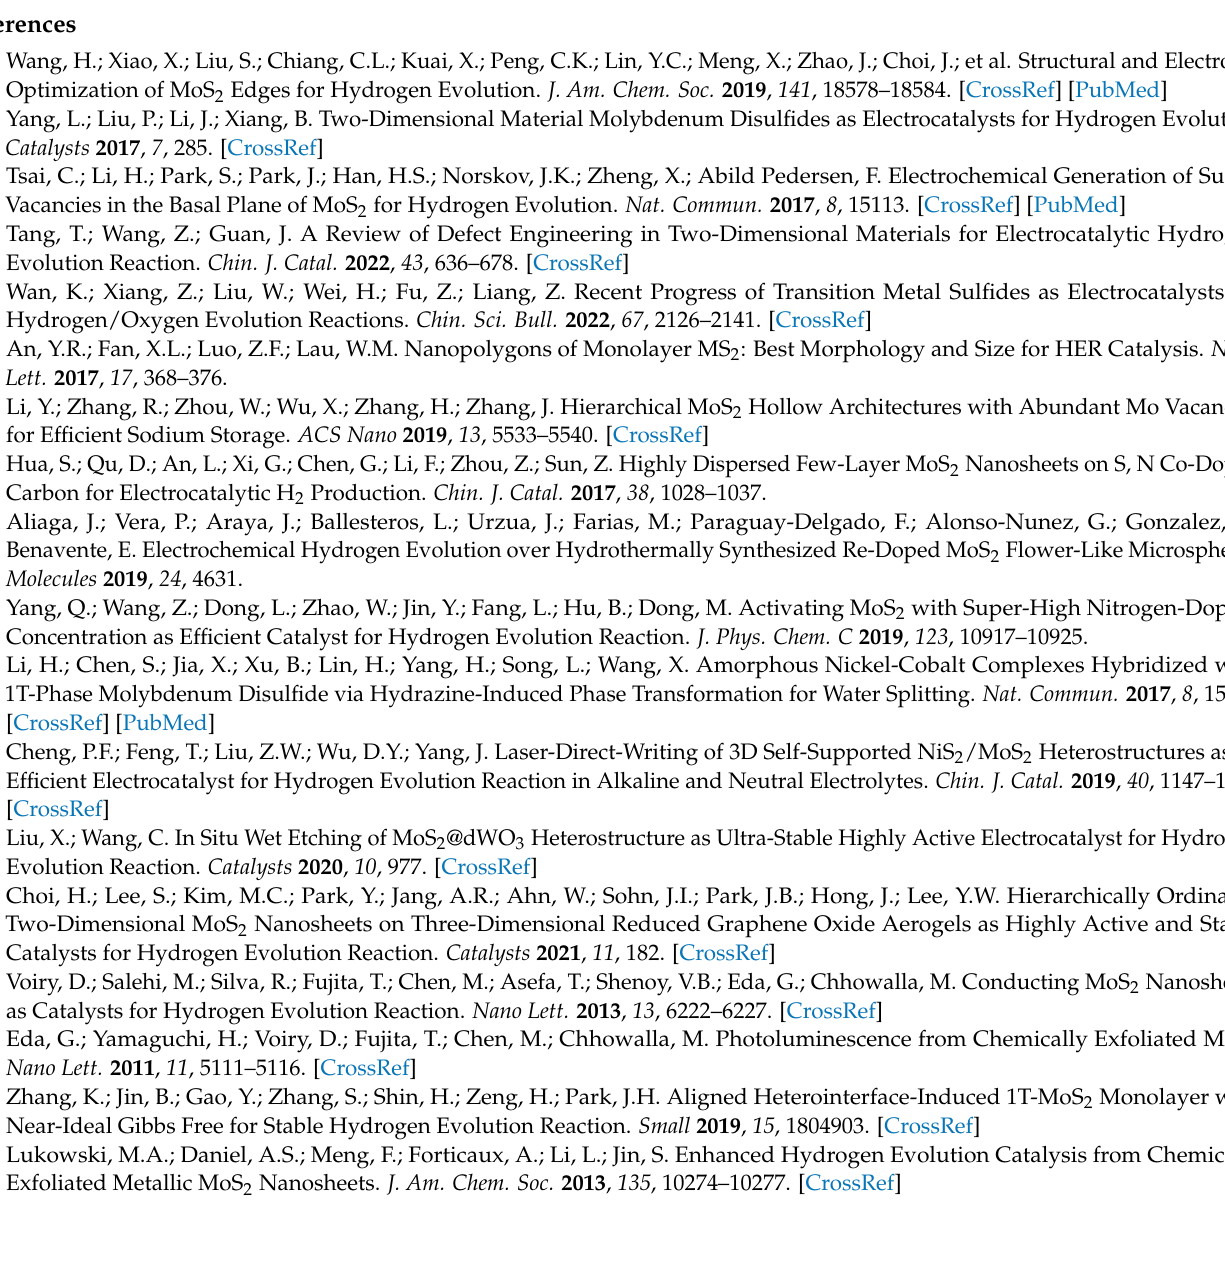
Figure S7: Performance comparison chart between different materials, Table S1: Comparisons of HER performance of the recently reported MoS 2 -based electrocatalysts in 1.0 M KOH. References [49–64] are cited in the supplementary